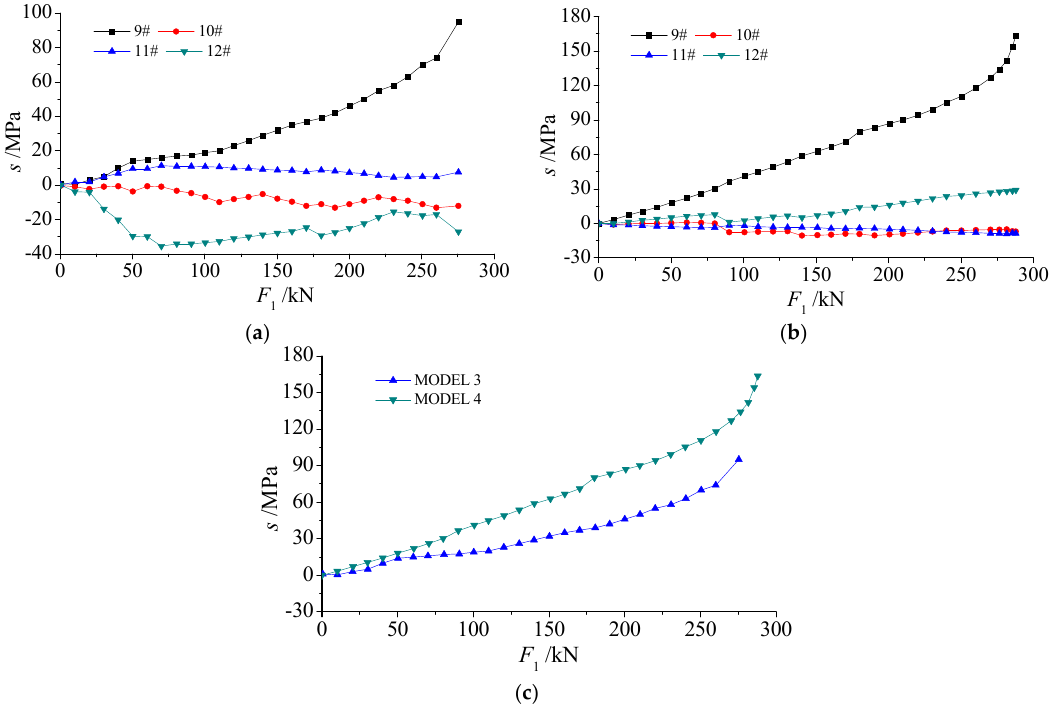
Figure 15. Stresses in roof beam: ( a ) stresses in model 3; ( b ) stresses in model 4; and, ( c ) comparison of stresses of gauge 9.